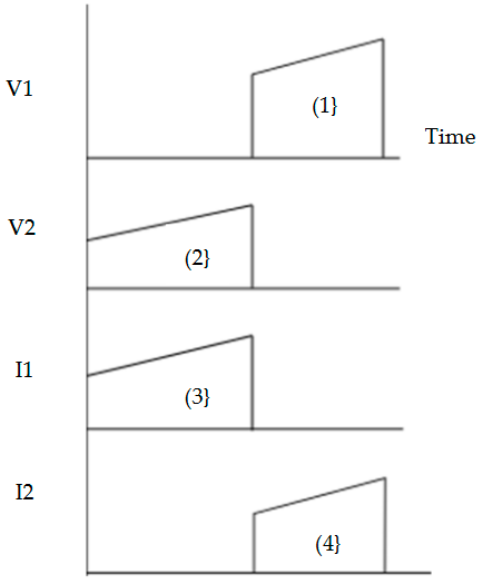
Figure 7. Switches separated.